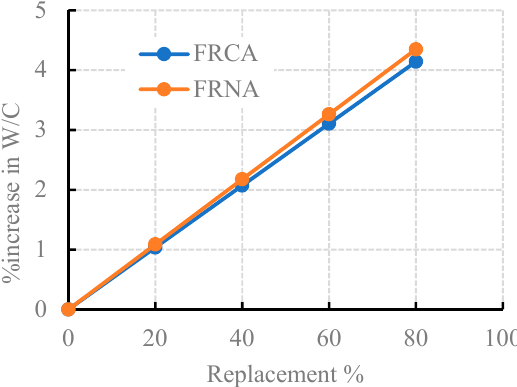
Figure 3. The percentage increase in the W/C ratio for RFCA and RFNA. Table 3. Concrete mixture proportions per 1 m 3 .